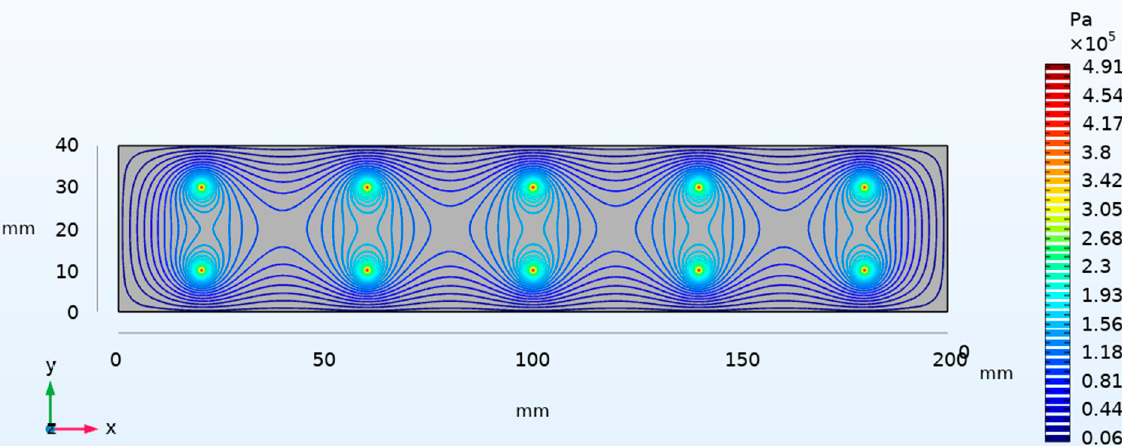
Figure 7. Pressure distribution of trial run.